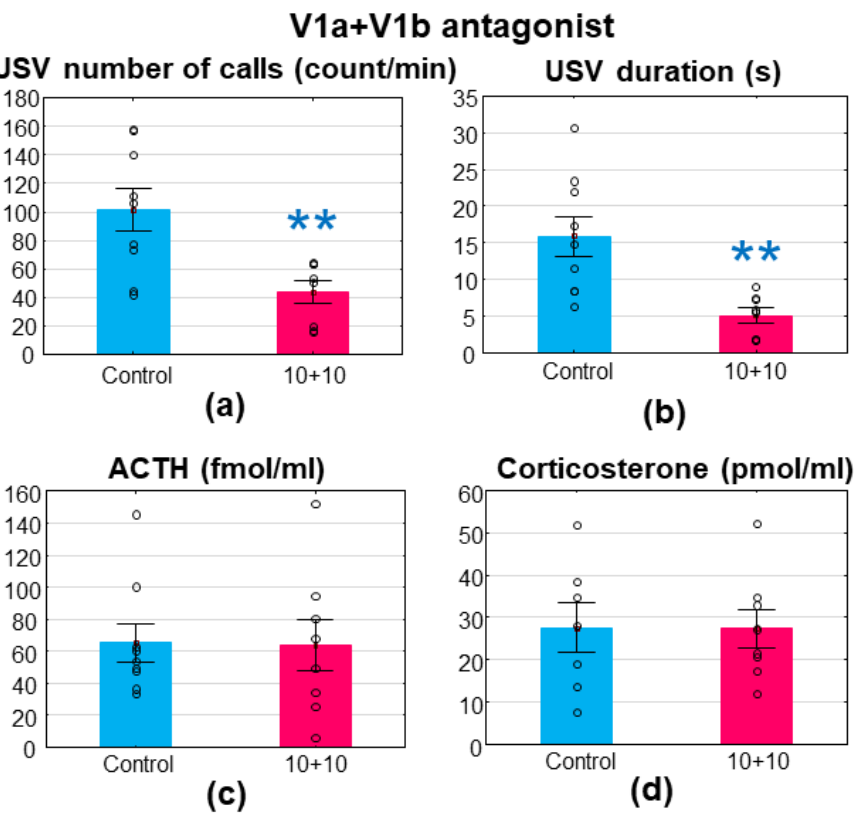
Figure 5. Wistar rats, treated with SR49059 (a vasopressin (V) 1aR) + SSR149415 (V1bR) antagonists. The 7–8-day-old Wistar rat pups were treated intraperitoneally with a mixture of 10 + 10 mg/kg V1aR + V1bR antagonists 30 min before a 10 min maternal separation. The combination significantly reduced the emitted ultrasonic vocalization both in terms of ( a ) the number of calls and ( b ) the duration without affecting the ( c ) adrenocorticotropin (ACTH, fmol/mL) or ( d ) corticosterone (pmol/mL) levels. n = 9–8. ** p < 0.01 vs. control.